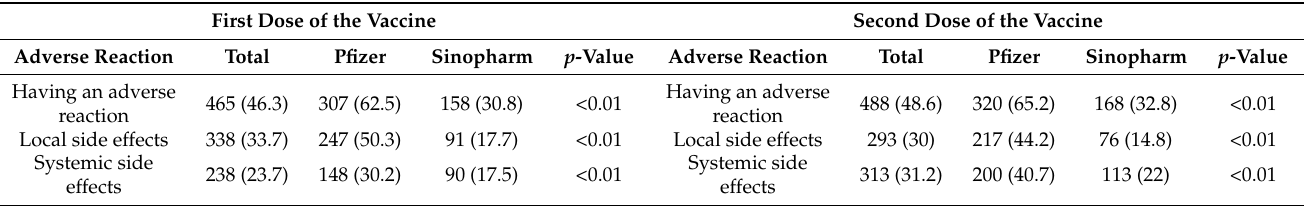
Table 2. Frequency and type of adverse reactions in terms of the used vaccine. First Dose of the